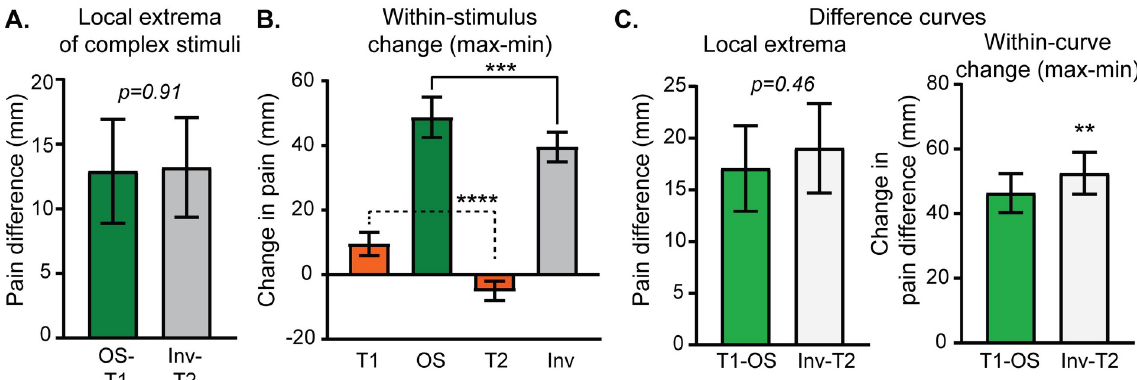
Fig 5. When controlled for adaptation by accounting for pain intensity changes during constant control stimuli, despite opposite directions of change, there is no significant difference in the change in absolute magnitude of pain report produced by stepped stimuli. A. The difference between pain intensity extrema (max for Inv, min for OS) and the pain intensity during control stimuli (T2 for Inv, T1 for OS), reflecting “a” arrows in Fig 1, was determined within each subject. B. Change in pain within stimulus (max—min, “b” arrows in Fig 1), for stepped stimuli and matched timepoints during control stimuli. A 1-way RM ANOVA showed significant main effect of stimulus. Post-hoc testing showed significant differences including those shown. C. Subtraction curves were analyzed within each subject for extrema and within- curve change. For all graphs, group mean with 95% CI error bars are plotted. P-values: �� p < 0.01, ��� p < 0.001, ���� p < 0.0001.